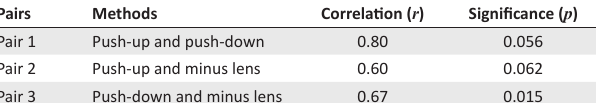
TABLE 2: Paired sample Pearson correlation coefficients for three procedures for amplitude of accommodation. Pairs Methods Correlation ( r ) Significance ( p ) Pair 1 Push-up and push-down 0.80 0.056 Push-up and minus lens